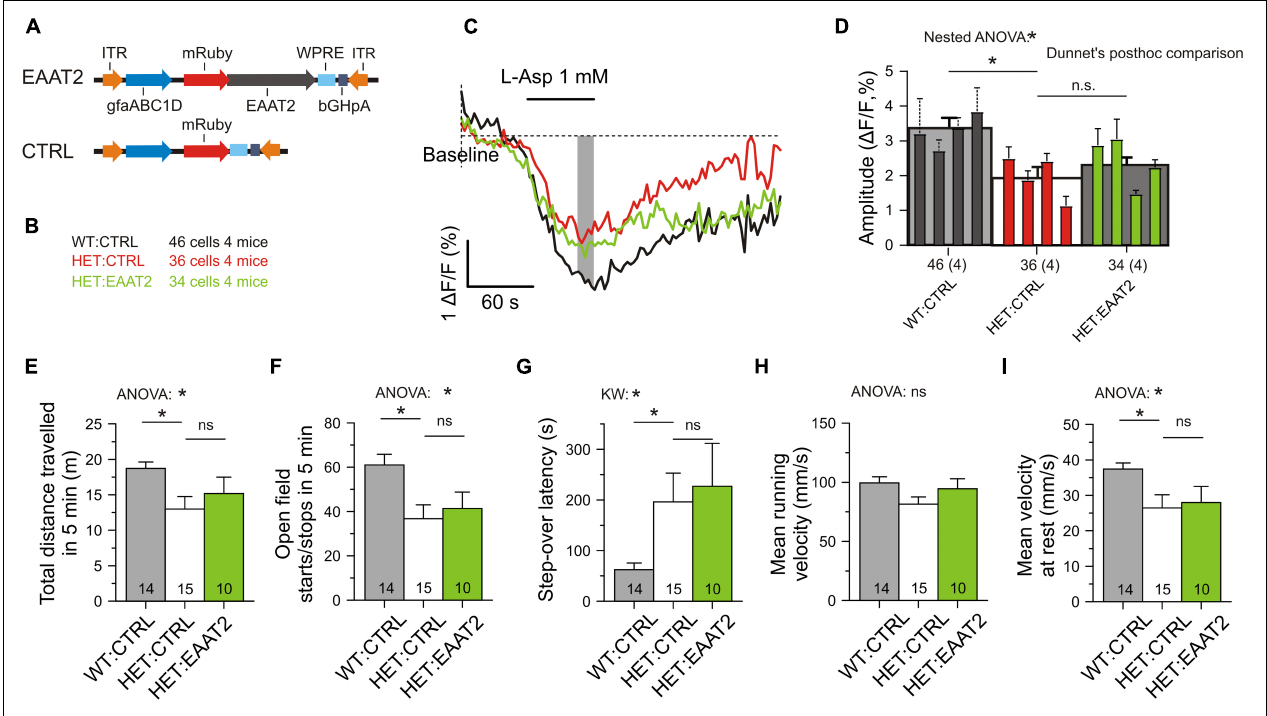
FIGURE 8 | No recovery of astrocytic glutamate uptake and motor performance in mice overexpressing the full-length form of EAAT2. (A) Injected vectors. (B) Animal groups. The injected animals were matched for age, body-weight and the number of CAG-repeats. The numbers refer to the experiments with SBFI imaging. (C) Measurement of single-cell glutamate uptake by sodium imaging with SBFI. Same conditions as in Figure 5 . Averaged traces from mRuby3+ astrocytes only. (D) Quantification of results with two-level (“nested”) ANOVA statistics (animal level and cell level) and two-level post hoc tests for the differences between the test groups. (E–I) Lack of recovery from the signs of hypokinesia. Here as in all other figures: n.s., not significant. * p <